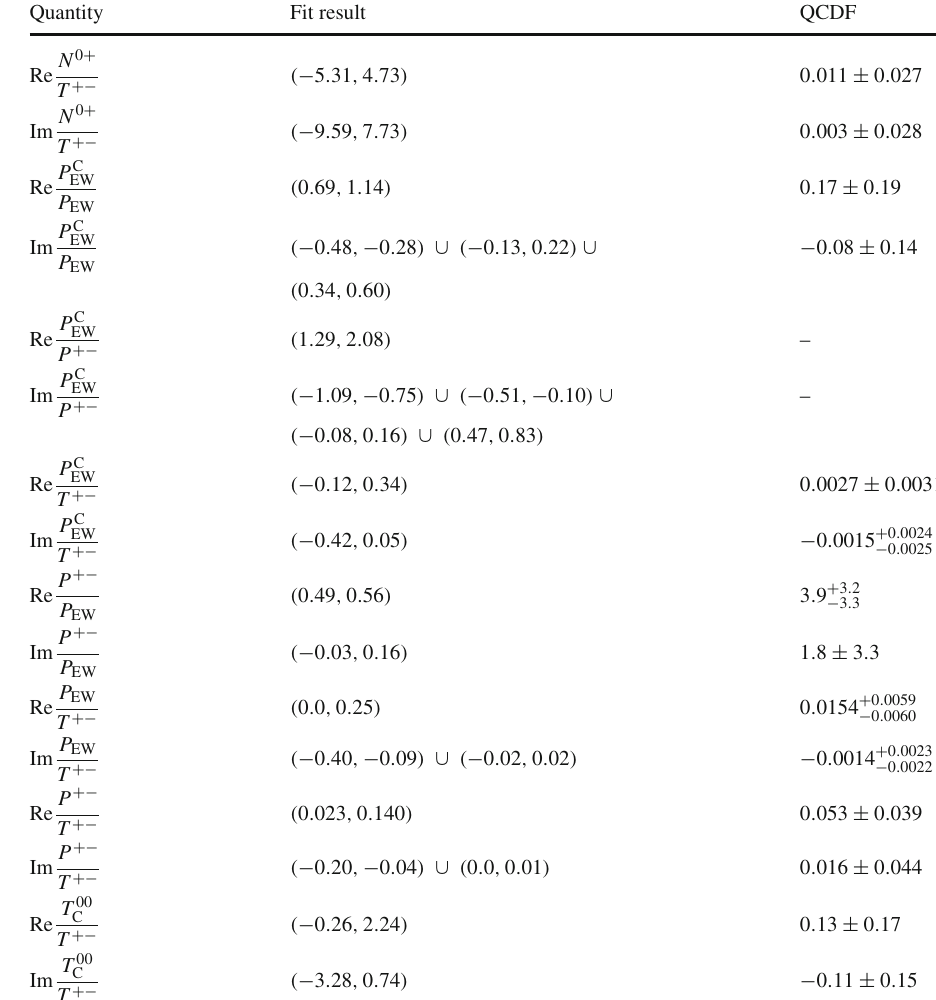
intervals for the real and imaginary parts of hadronic ratios according to our fit and the corresponding predictions in our implementation of QCD factorisation (QCDF). No prediction is given for the ratio / P +− due to numerical P C EW instabilities (see